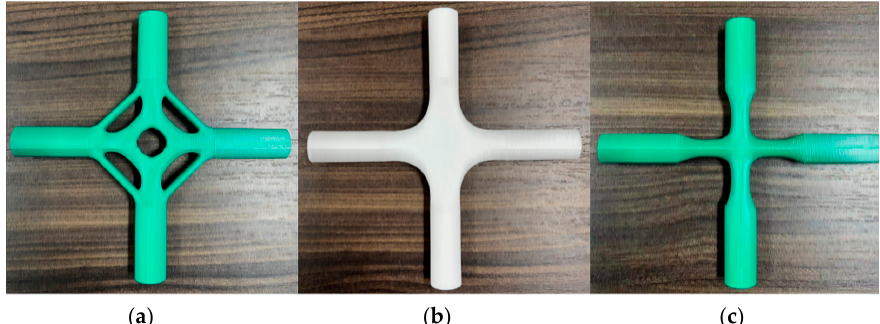
Figure 17. Solid models printed by the FDM 3D printer: ( a ) generative joint 1, ( b ) generative joint 2, ( c ) generative joint 3. ( c ) generative joint